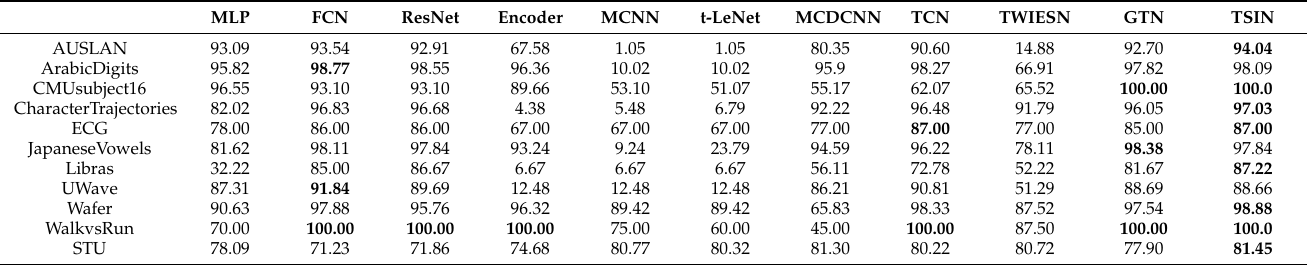
Table 2. Test accuracy of the TSIN and other benchmark models on the multivariate time-series